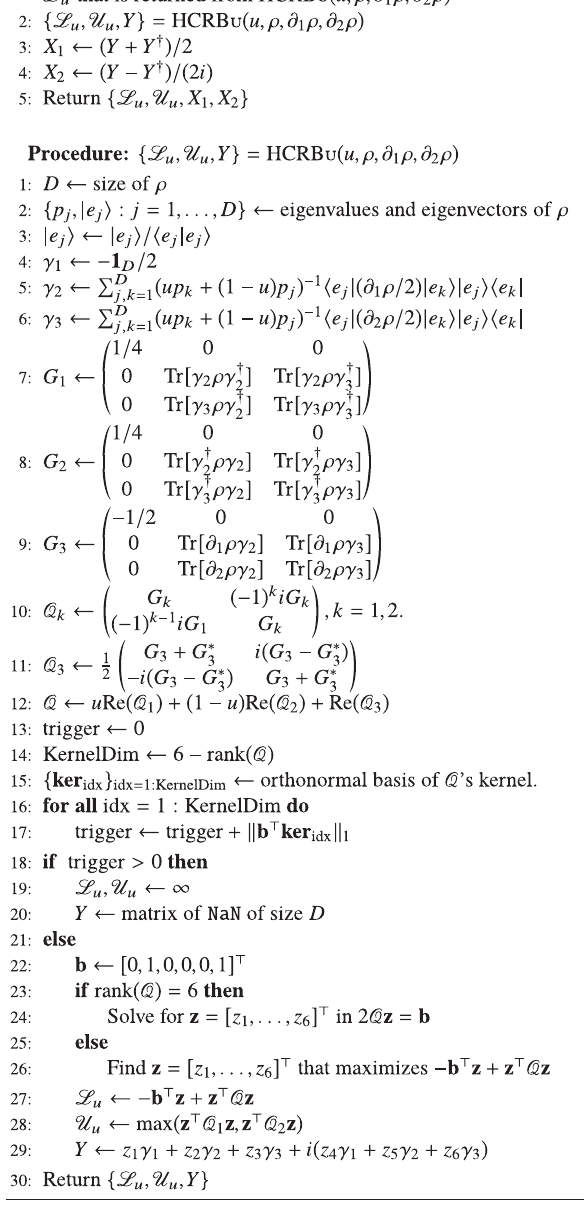
FIG. 4. Master algorithm to generate the analytic form of the two-parameter